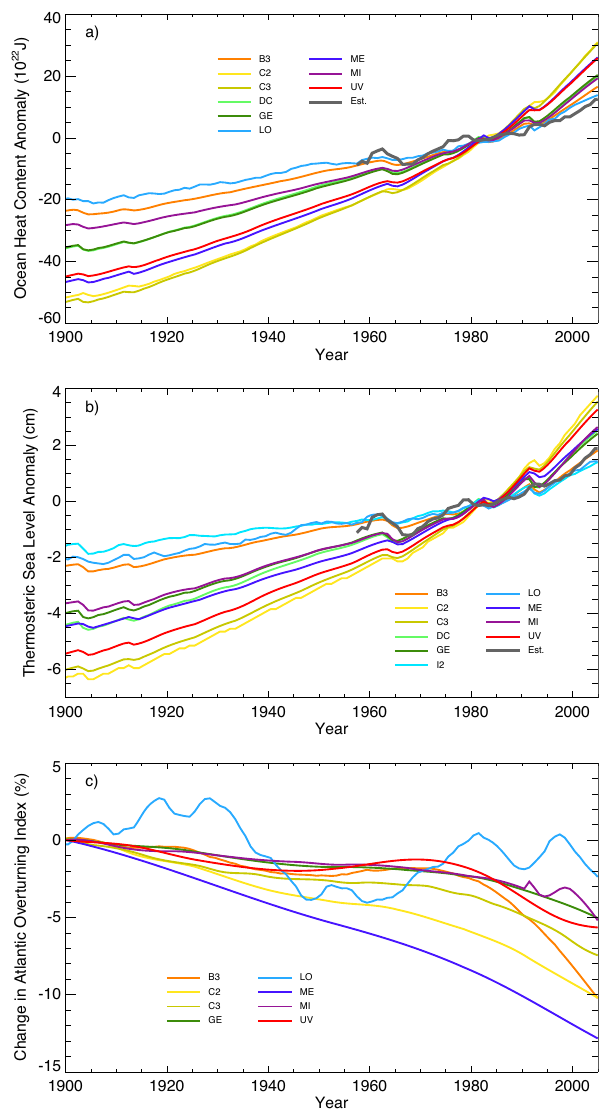
Fig. 3. Changes in global ocean heat content (a) , thermosteric sea level rise (b) , and North Atlantic overturning index (c) over the last century. The dark grey lines are estimates of the change in heat con- tent (a) , and the thermosteric component of sea level change (b) , of the first 2000m of the ocean, from Levitus et al. (2012). Ocean heat content (a) and thermosteric sea level (b) are plotted as anomalies from the year 1957 to 2005 average. Note that the model heat con- tent and sea level changes are averages over the entire ocean so these would be expected to be somewhat larger than the values estimated over the first 2000m. The North Atlantic overturning index (c) is shown as a percent change from the decade centred at year 1900 and was processed with a 30yr moving average, rectangular